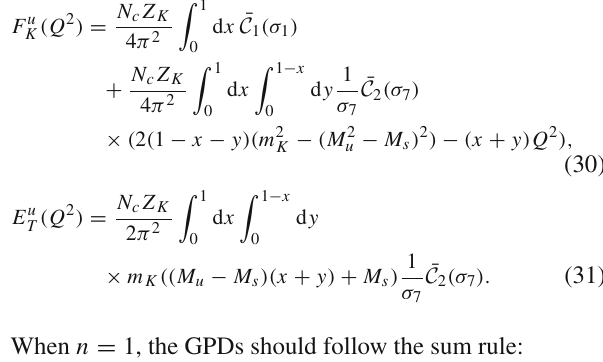
is softer than B u 1 , 0